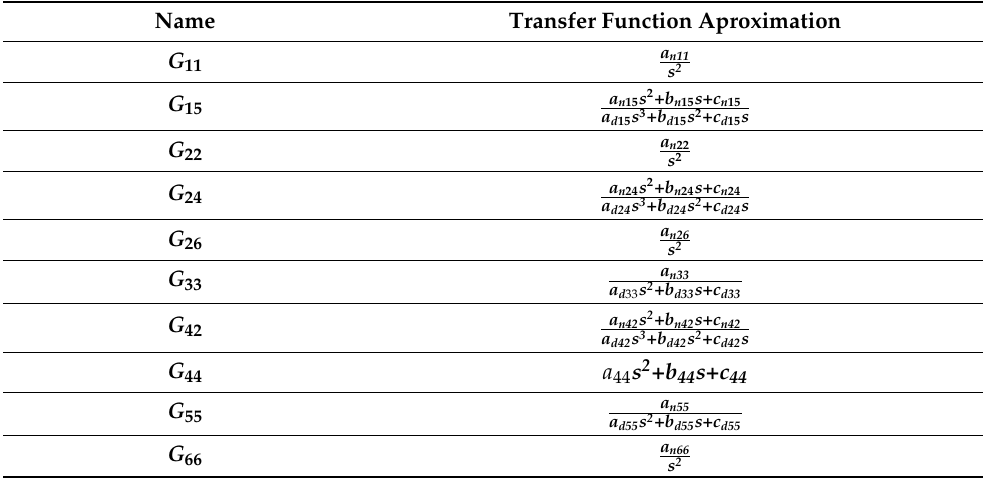
Figure 2. Structure of the linear approximation for a caissons’ draft of 10.75 m. Table 1. Family of transfer functions of the linear approximation